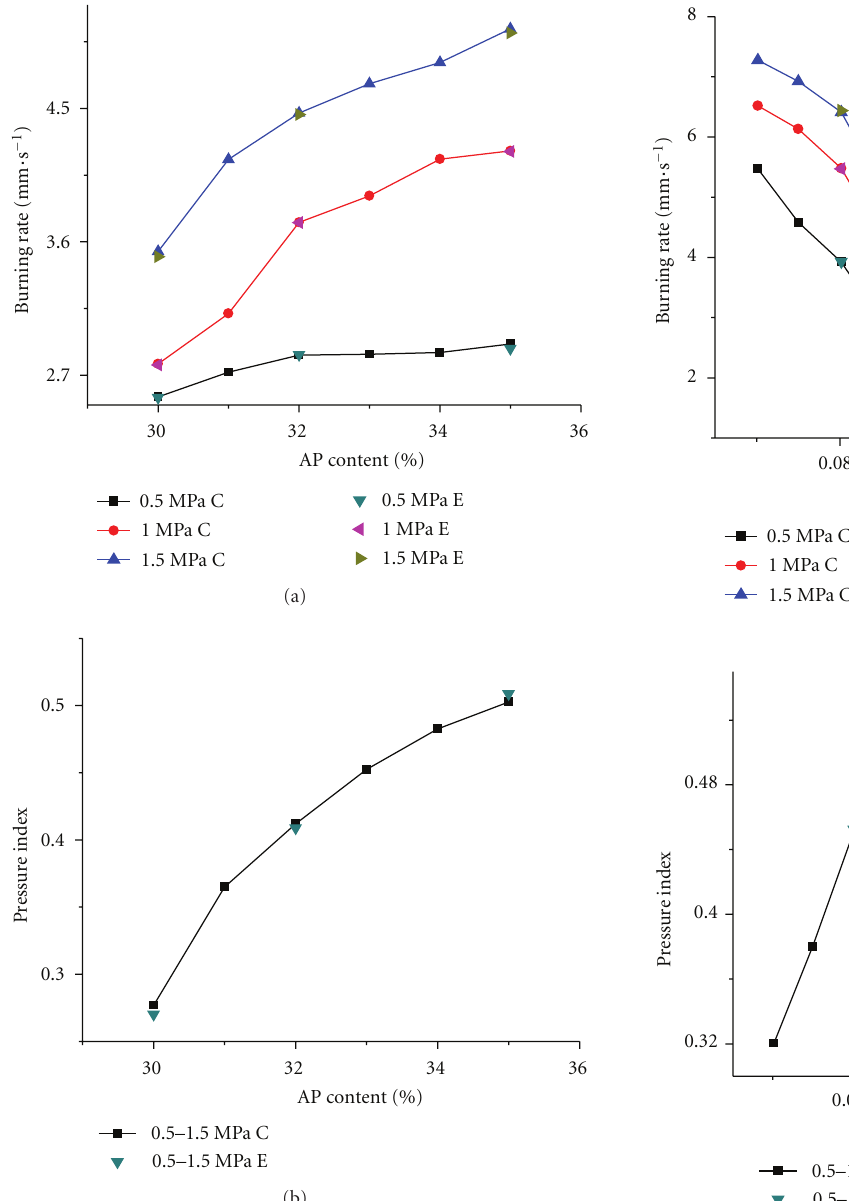
Figure 3: E ff ect of AP content (wt%) on burning rate (a) and pressure index (b). Figure 4: E ff ect of AP particle size on burning rate (a) and pressure